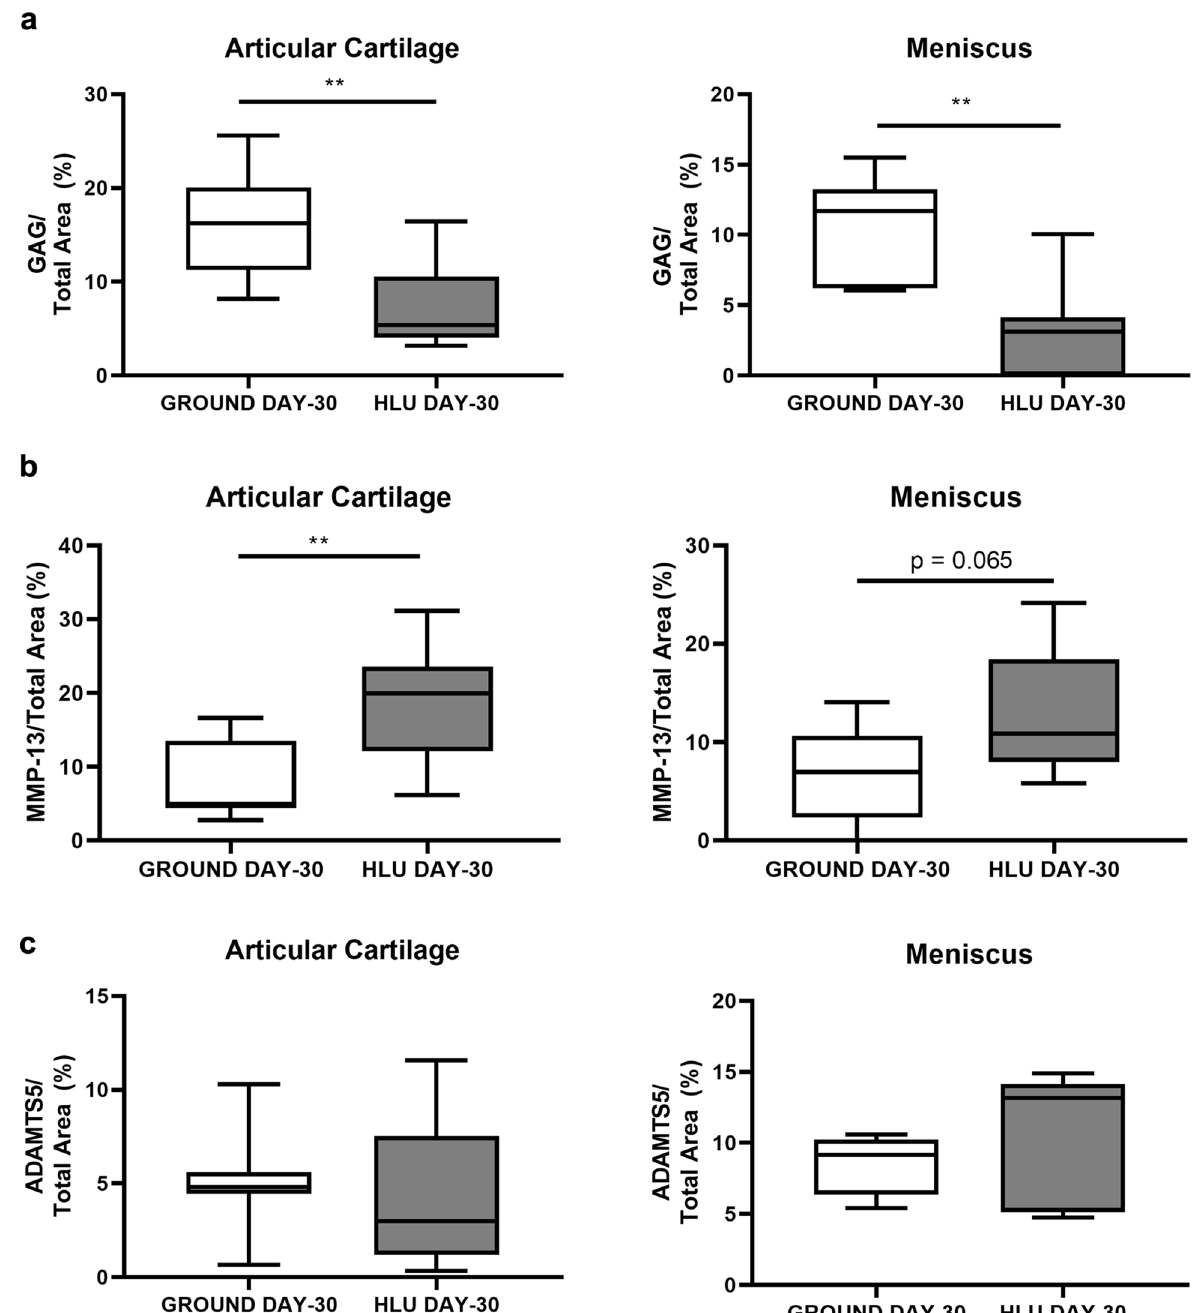
Figure 6. Sulfated glycosaminoglycan (GAG) abundance was lower and catabolic enzymes elevated within the articular cartilage lining the medial tibial plateau and the medial menisci from mice after HLU. ( a ) Sulfated GAG abundance was lower in both the articular cartilage and menisci after 30 Days of HLU (n = 7–8/group). ( b ) MMP-13 was significantly increased in the articular cartilage after HLU, and was marginally greater in the meniscus (n = 7–8/group). ( c ) ADAMTS5 was similar between both GROUND and HLU on Day 30 (n = 7–8/ group). ** p <